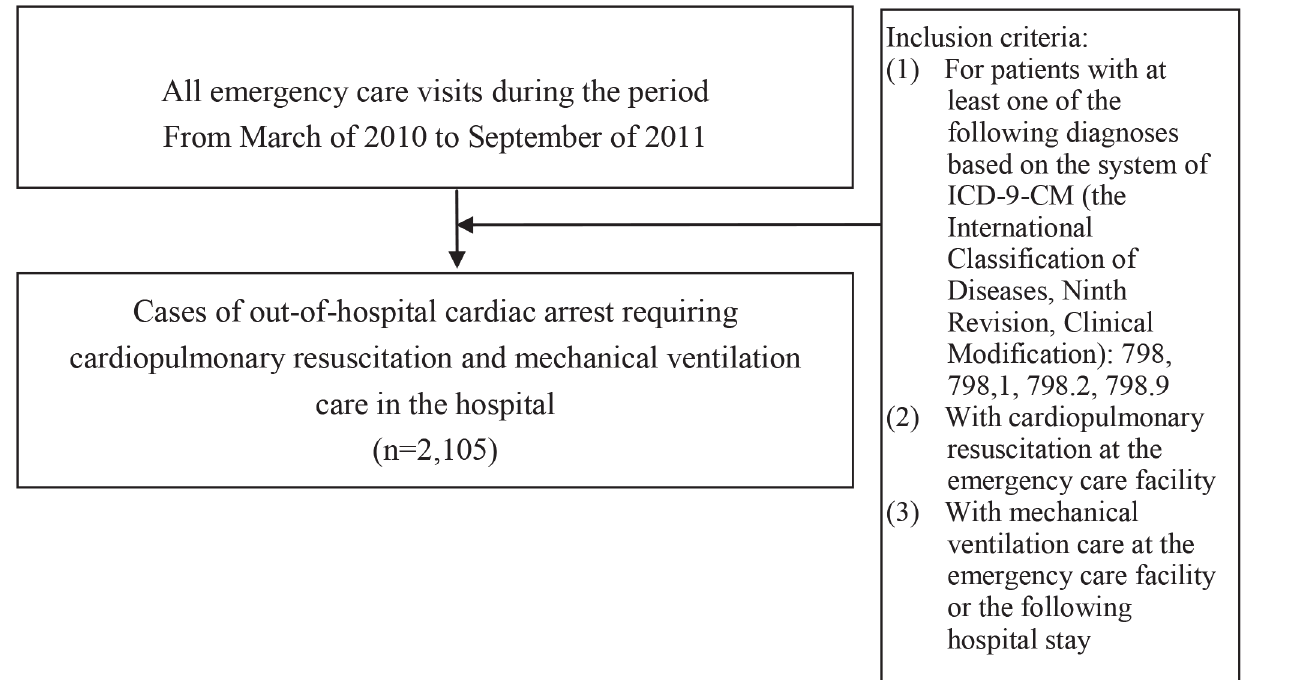
Fig 2. Selection of study subjects with out-of-hospital cardiac arrest requiring cardiopulmonary resuscitation and mechanical ventilation.